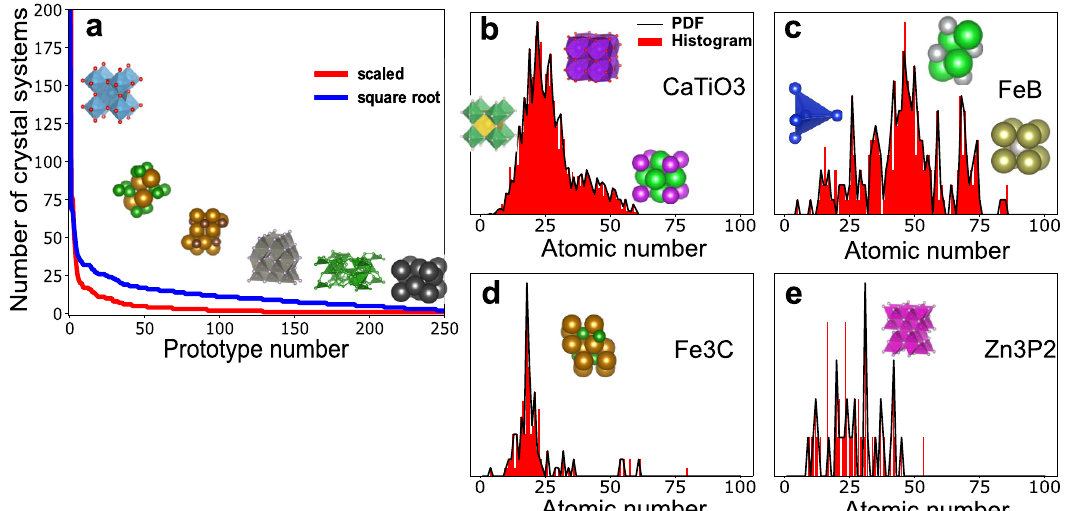
Fig. 7 Crystal system extraction from the materials project database. a Number of crystal systems chosen from each prototype systems for the training dataset. b – e Atomic number distribution of crystal systems belonging to the same prototype system as b CaTiO 3 , c FeB, d Fe 3 C, e Zn 3 P 2